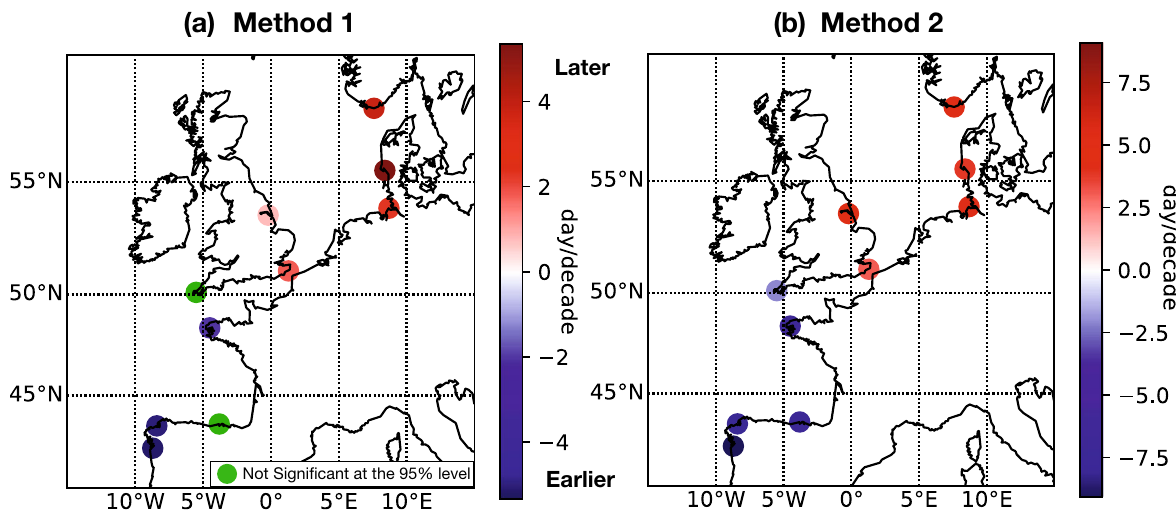
Figure 3. Shift of the timing of the storm surge season between 1950 and 2000, the storm surge timing being computed with ( a ) the GEV analysis referred to as method 1 ( b ) the non parametric method referred to as method 2. The shift corresponds to the linear trend between 1950 and 2000. Note that the color bars have different range.